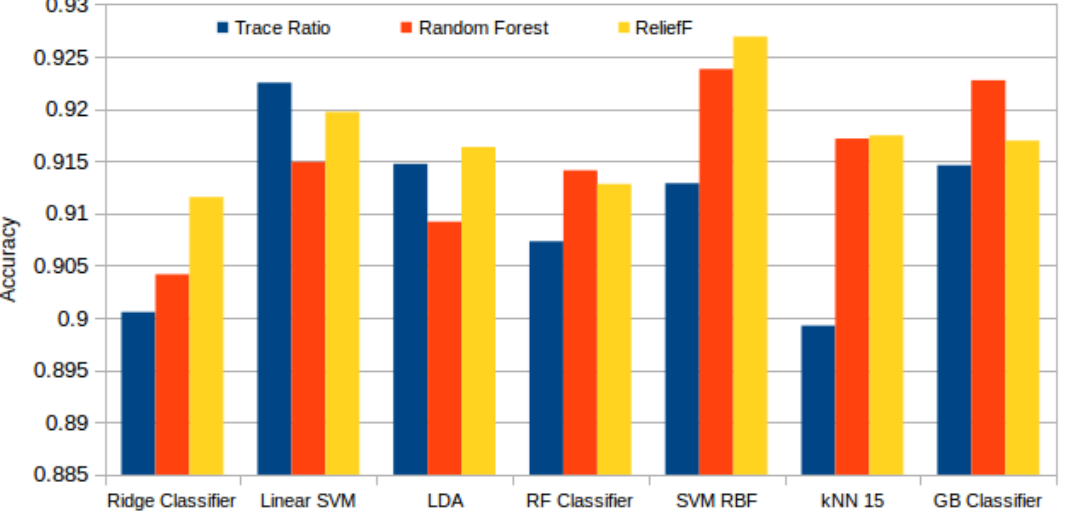
Figure 13. Best mean accuracy achieved by each classifier and